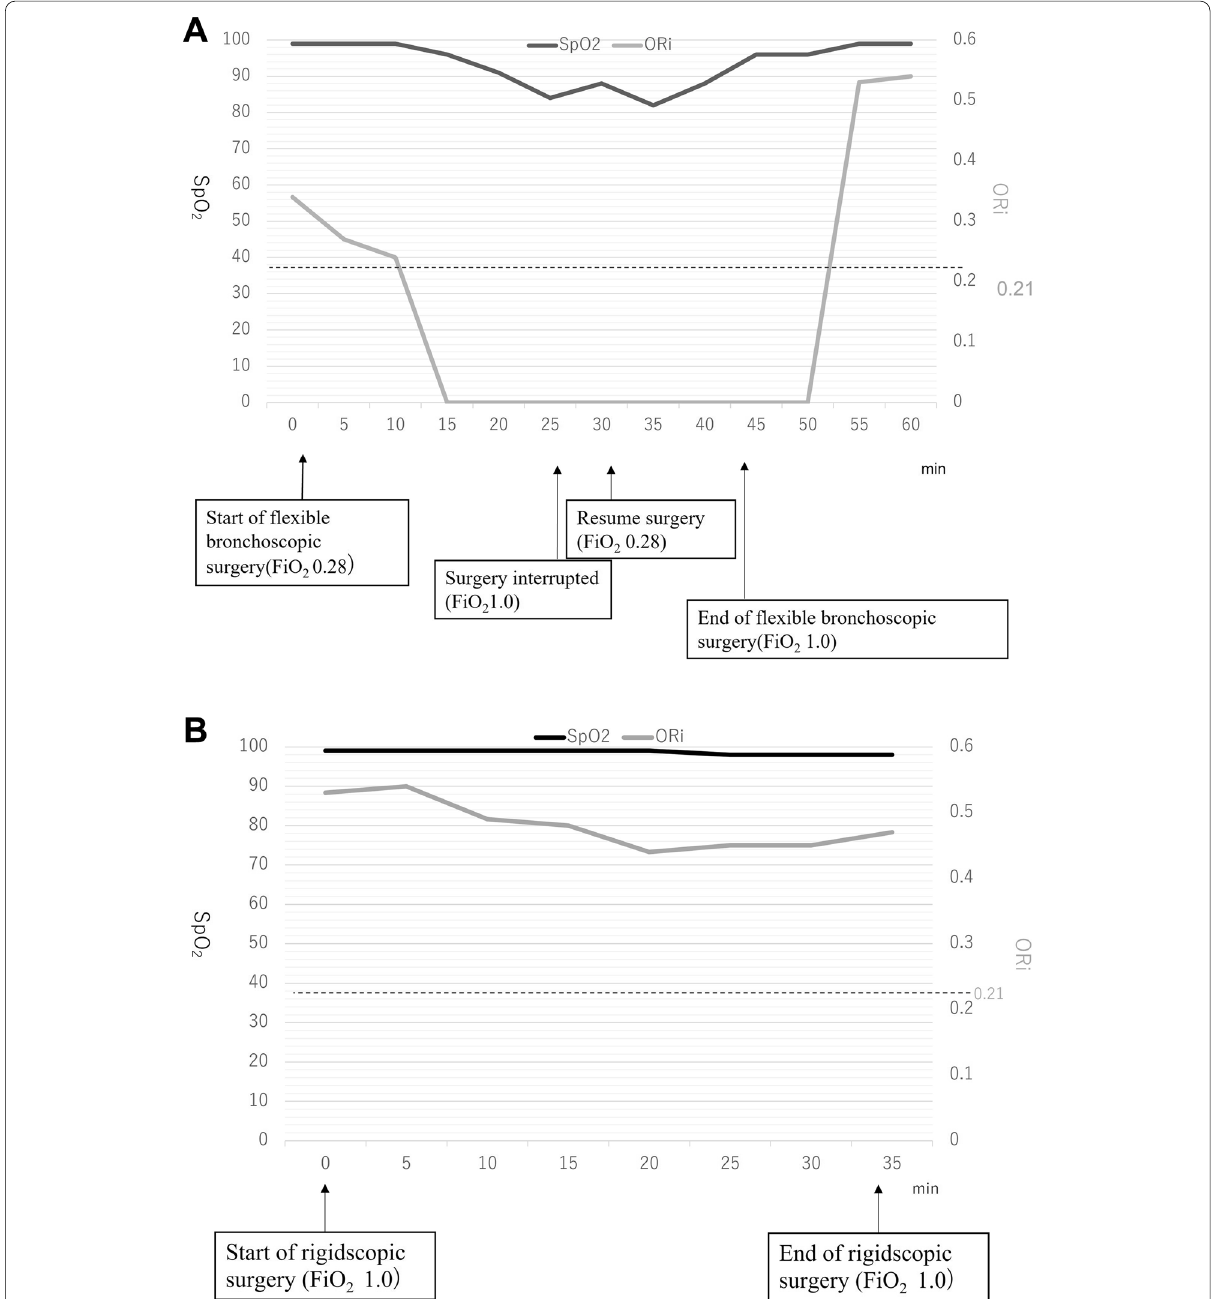
Fig. 1 Oxygen reserve index (ORi ™ ) and peripheral oxygen saturation during surgery using flexible ( a ) and rigid ( b ) bronchoscopes. a ORi reduced immediately after starting surgery. It decreased to 0.21, when SpO2 began to decrease. There were few minutes between the onset of decrease of ORi and of SpO2. b ORi was maintained above 0.4, and SpO2 did not decrease during surgery with a rigid